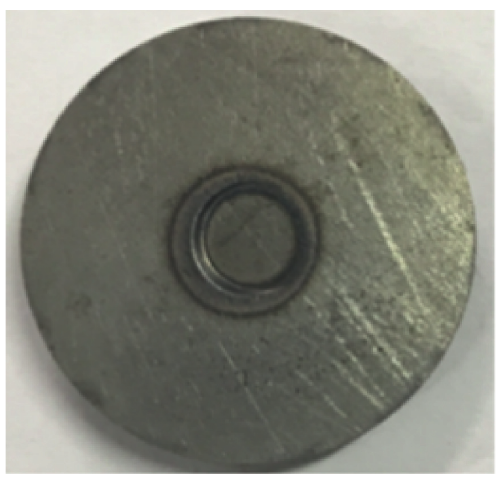
Figure 1: The overlap structure of